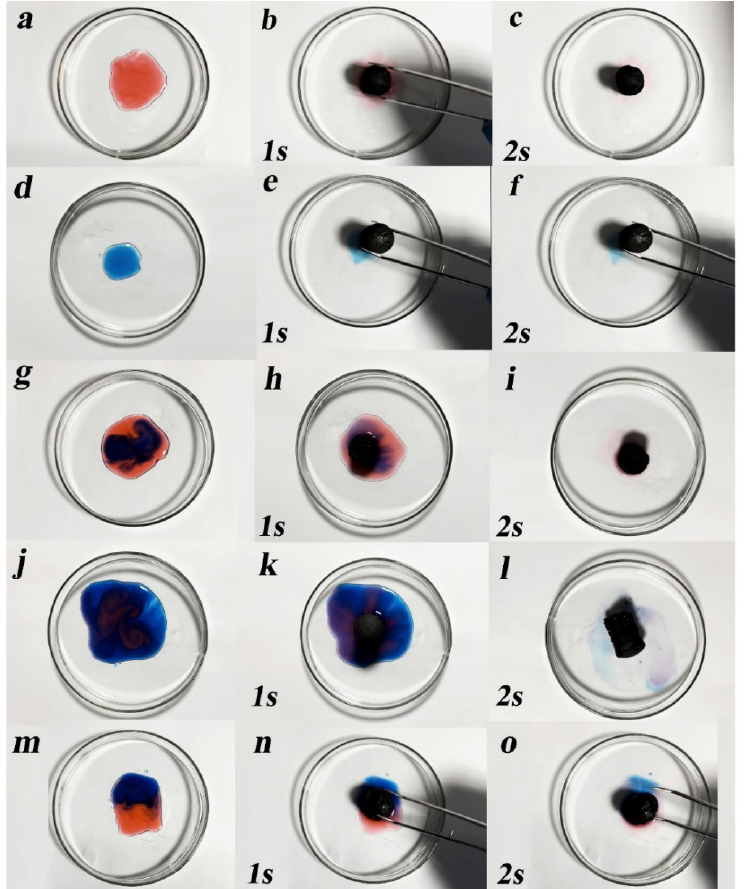
Figure 8. Adsorption capacity of the GA-MCC-PEI-4 aerogel for ( a – c ) amaranth, ( d – f ) methylene blue, ( g – i ) mixture of amaranth and methylene blue (more amaranth), ( j – l ) mixture of amaranth and methylene blue (more methylene blue), and ( m – o ) mixture of equal amounts of amaranth and methylene blue within 1 s and 2 s.